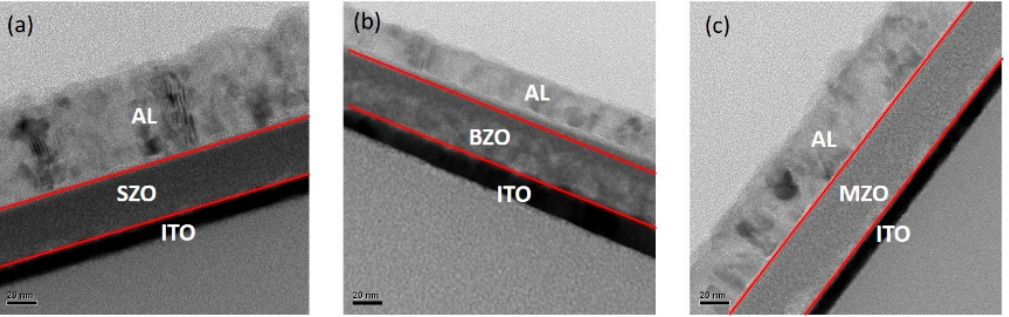
Figure 1. Cross-sectional TEM images of Al/( a )strontium zirconate (SZO), ( b )barium zirconate (BZO), and ( c )magnesium zirconate (MZO) /ITO/glass devices.